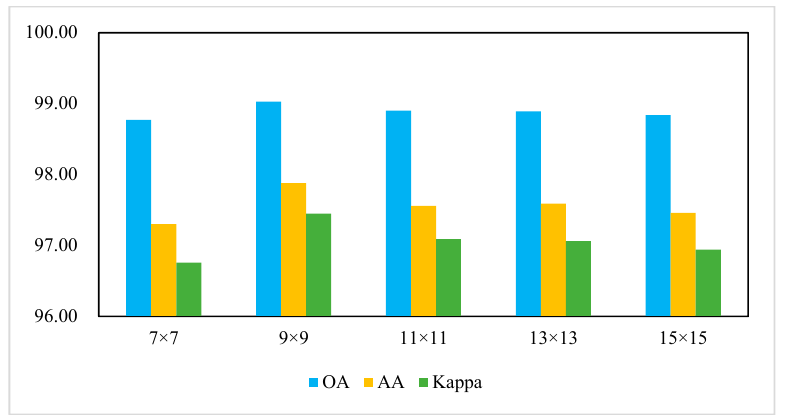
Figure 8. Analysis of neighbor size on the classification performances of SSFIN for dataset 1 classification.